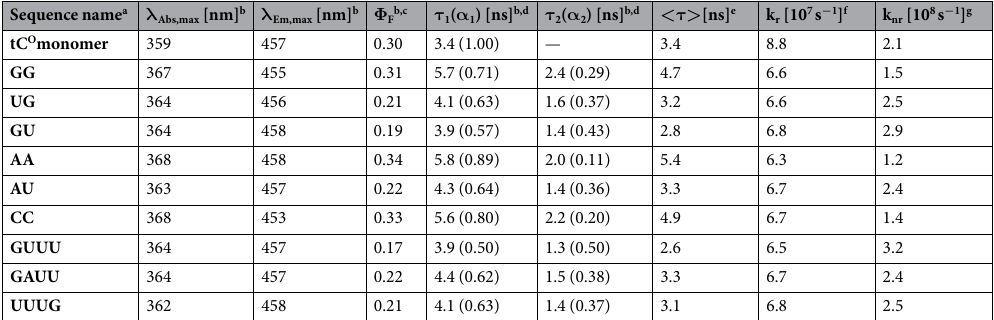
Table 2. Optical properties of the tC O monomer and tC O -containing RNA single strands. a Sequences are named after the bases flanking tC O (see Fig. 1b). Full sequences can be found as Supplementary Table S1. b Measurements were performed in PBS buffer (100 mM Na + , pH 7.5). c Fluorescence quantum yields are measured relative to the quantum yield of the potassium salt of the tC O -monomer in water ( Φ F = 0.30) 31 . d The amplitudes are indicated in parenthesis. e Mean fluorescence lifetime <τ> = ∑α constant, k r = Φ F / <τ> . g Non-radiative rate constant, k nr = k r / Φ F − k r